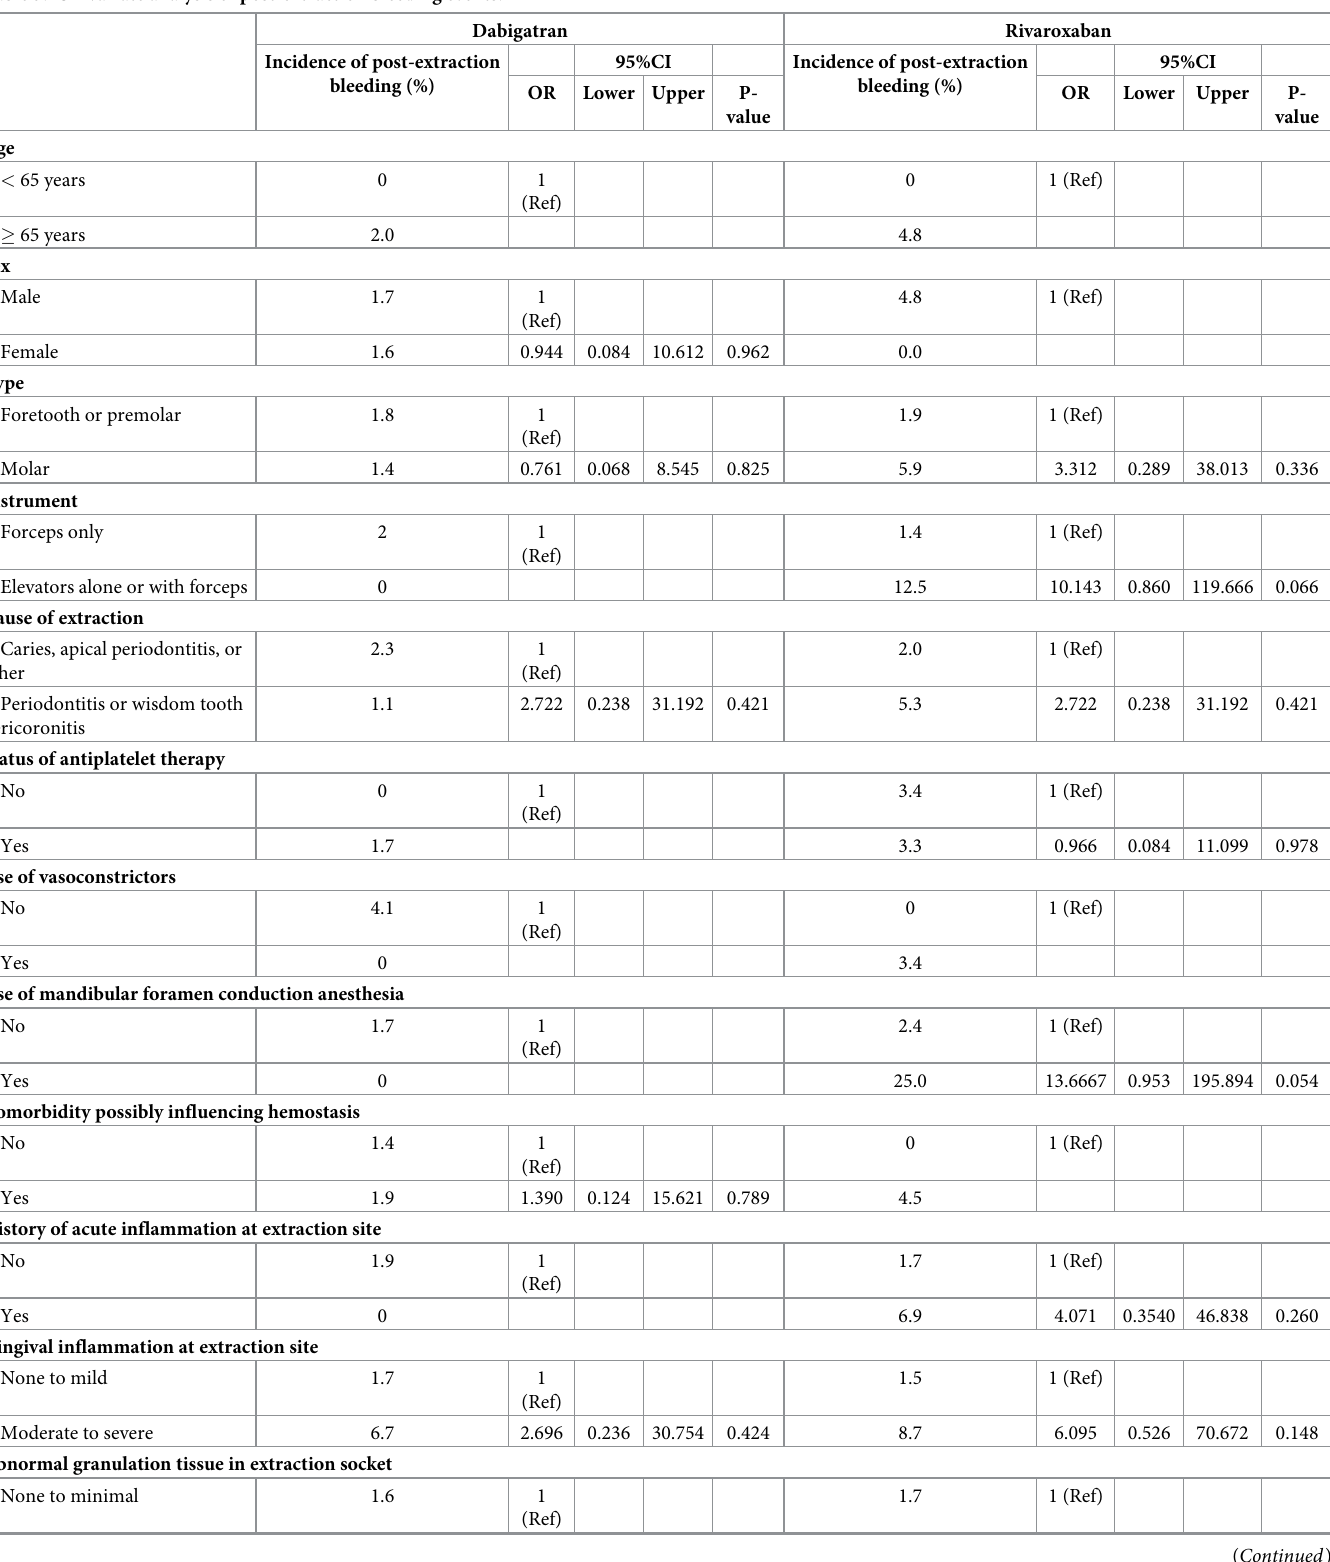
Table 3. Univariate analysis of post-extraction bleeding